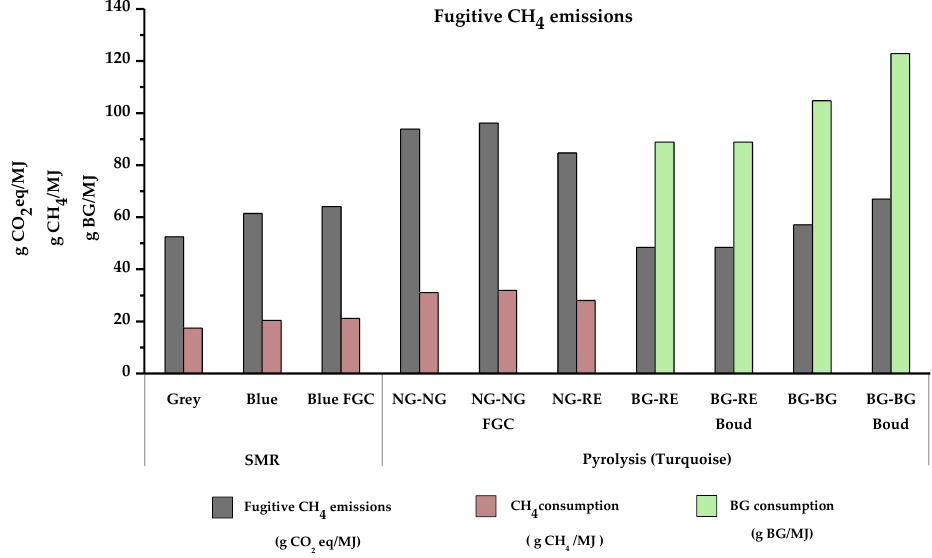
Figure 9. The fugitive methane emissions from grey, blue, and turquoise hydrogen production.